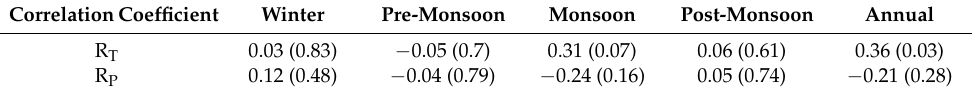
Table 3. Annual and seasonal correlation coefficients between NDVI and temperature (R T ) and precipitation (R P ) in Nepal from 1982–2015; the values in parentheses refer to the p values of the correlation coefficients.